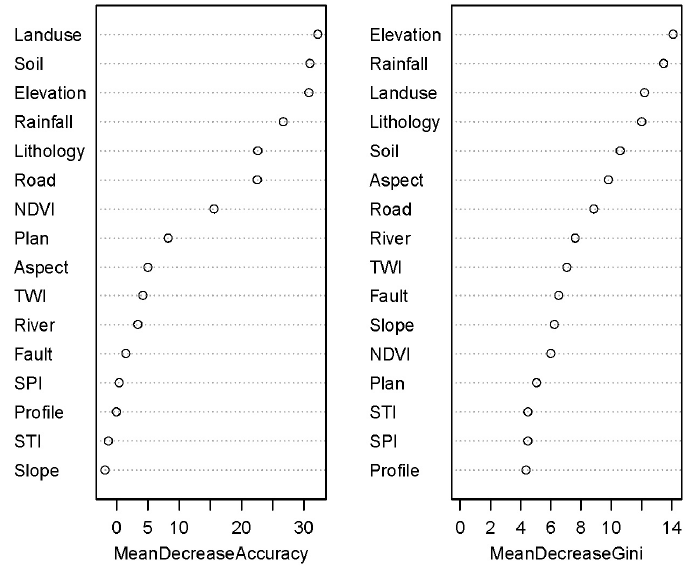
Figure 6. Mean decrease accuracy and mean decrease Gini.